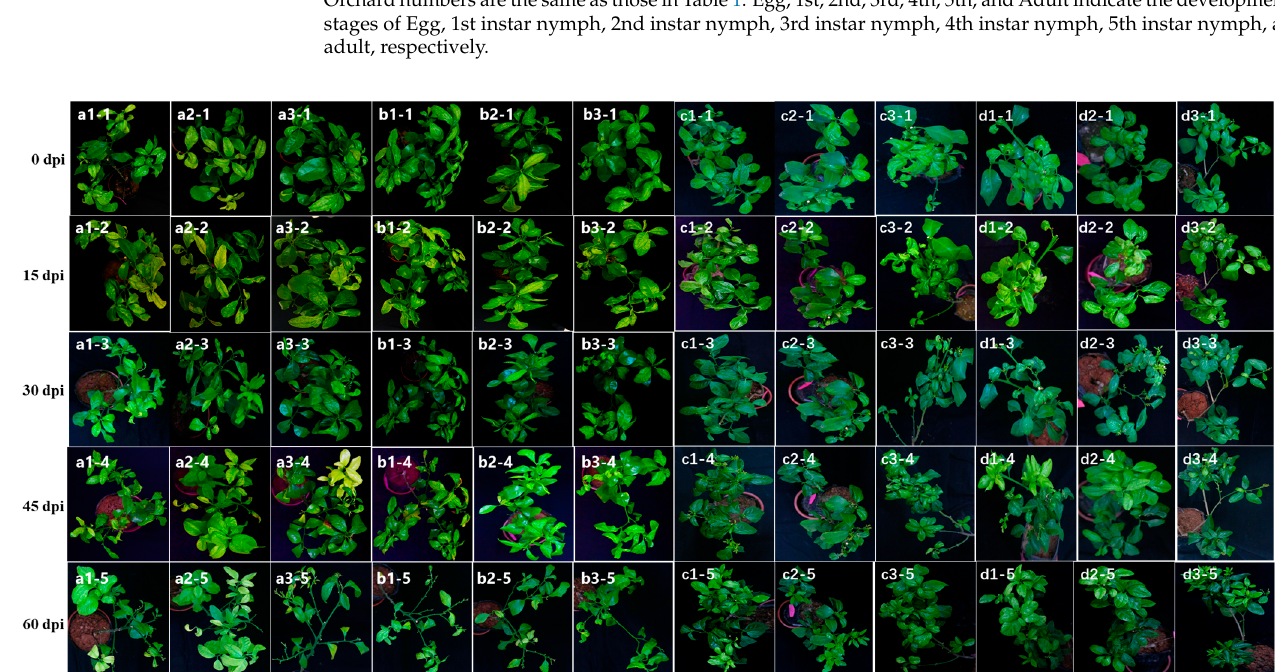
Figure A1. Symptoms of Citrus reticulata Blanco “Shatangju” at different periods after inoculation by CLas+ D. citri , healthy D. citri , CLas+ CTV+ D. citri, and CTV+ D. citri . a, “Shatangju” plants inoculated by CLas + D. citri ; b, Plants inoculated by healthy D. citri ; c, Plants inoculated by CLas + CTV + D. citri ; d, Plants inoculated by CTV + D. citri ; Three replicates were set for each experimental treatment; dpi: days post-inoculation.